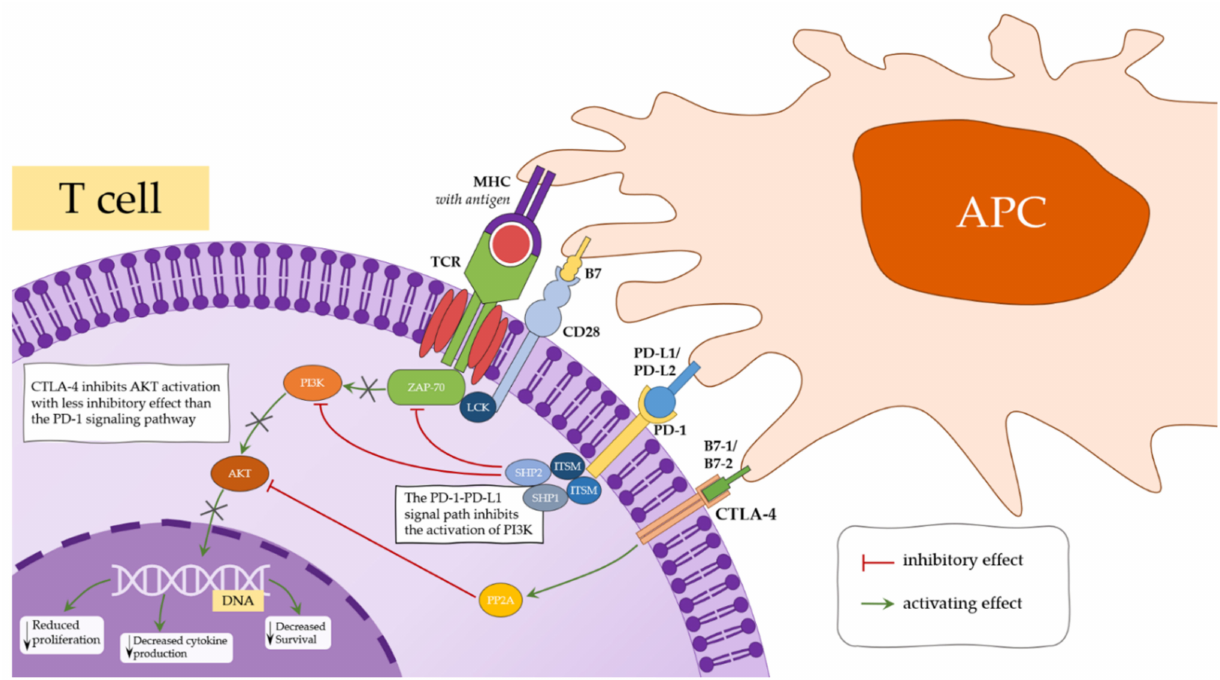
Figure 2. The main immunity pathways involved in